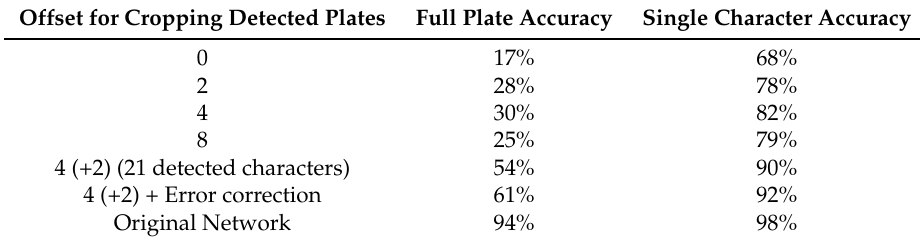
Table 3. Classification accuracy of character detector and localizer network.